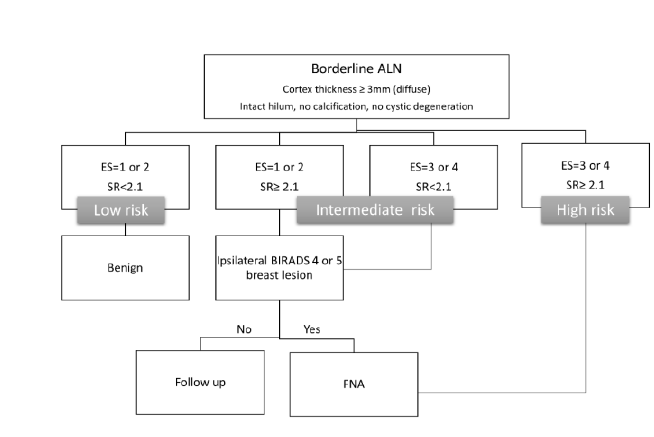
Figure 3 . A flow chart illustrates a management algorithm for borderline axillary lymph nodes. Abbreviation, axillary lymph nodes (ALN), elasticity score (ES), strain ratio